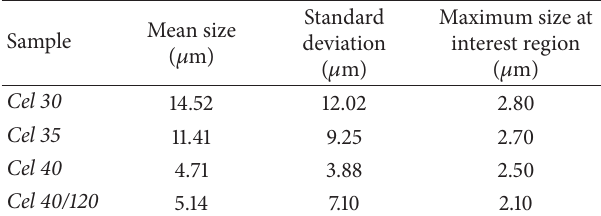
Table 3: Particle size analysis of the cellulose particles after heat treatment and milling.